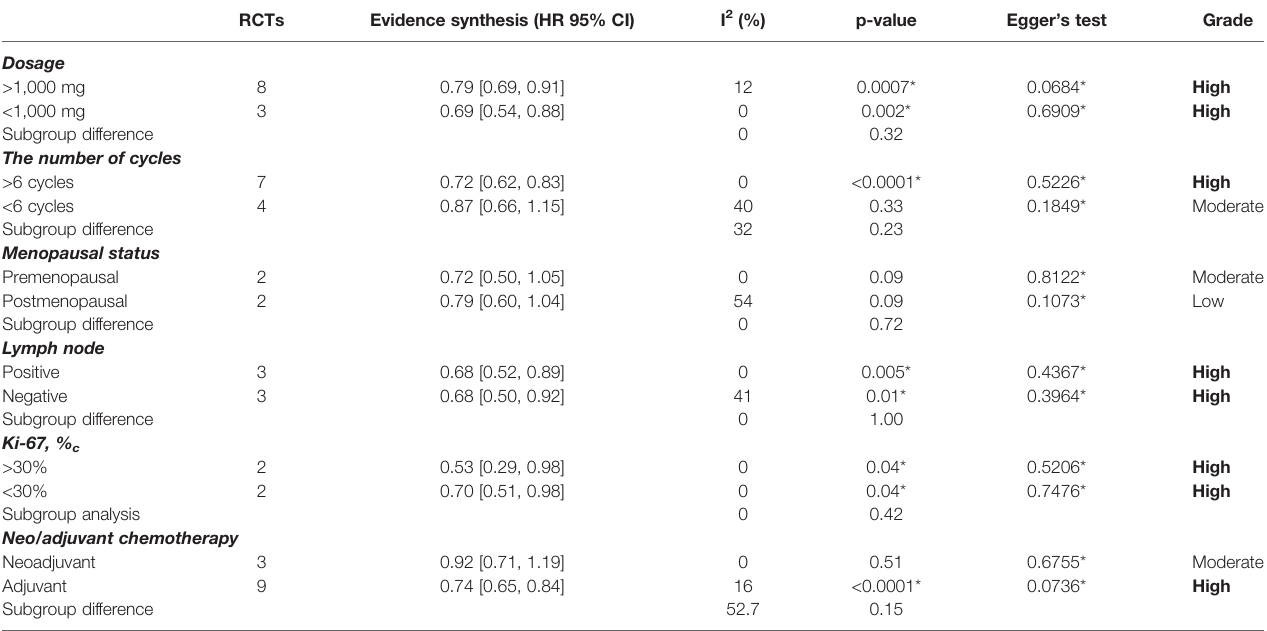
TABLE 2 | Outcomes of subgroup